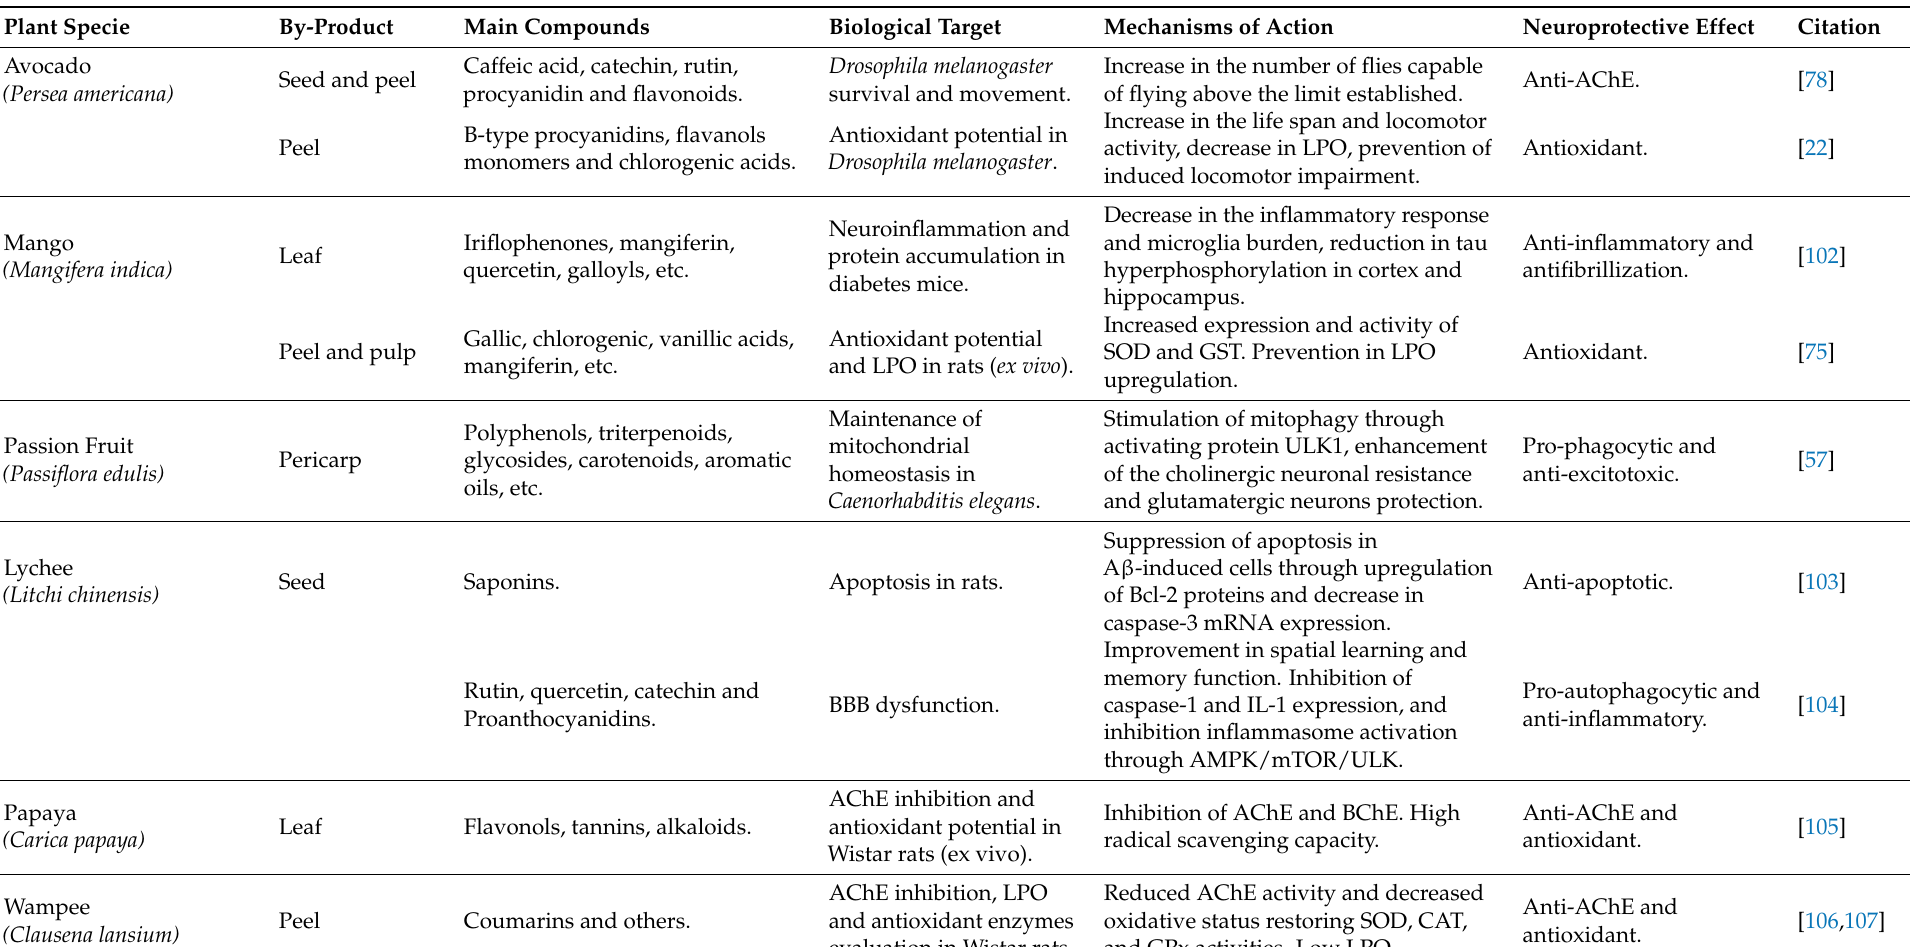
Table 2. Different in vivo studies where fruit and vegetable by-product extracts rich in phenolic compounds (and other bioactives) were tested in neurodegenerative